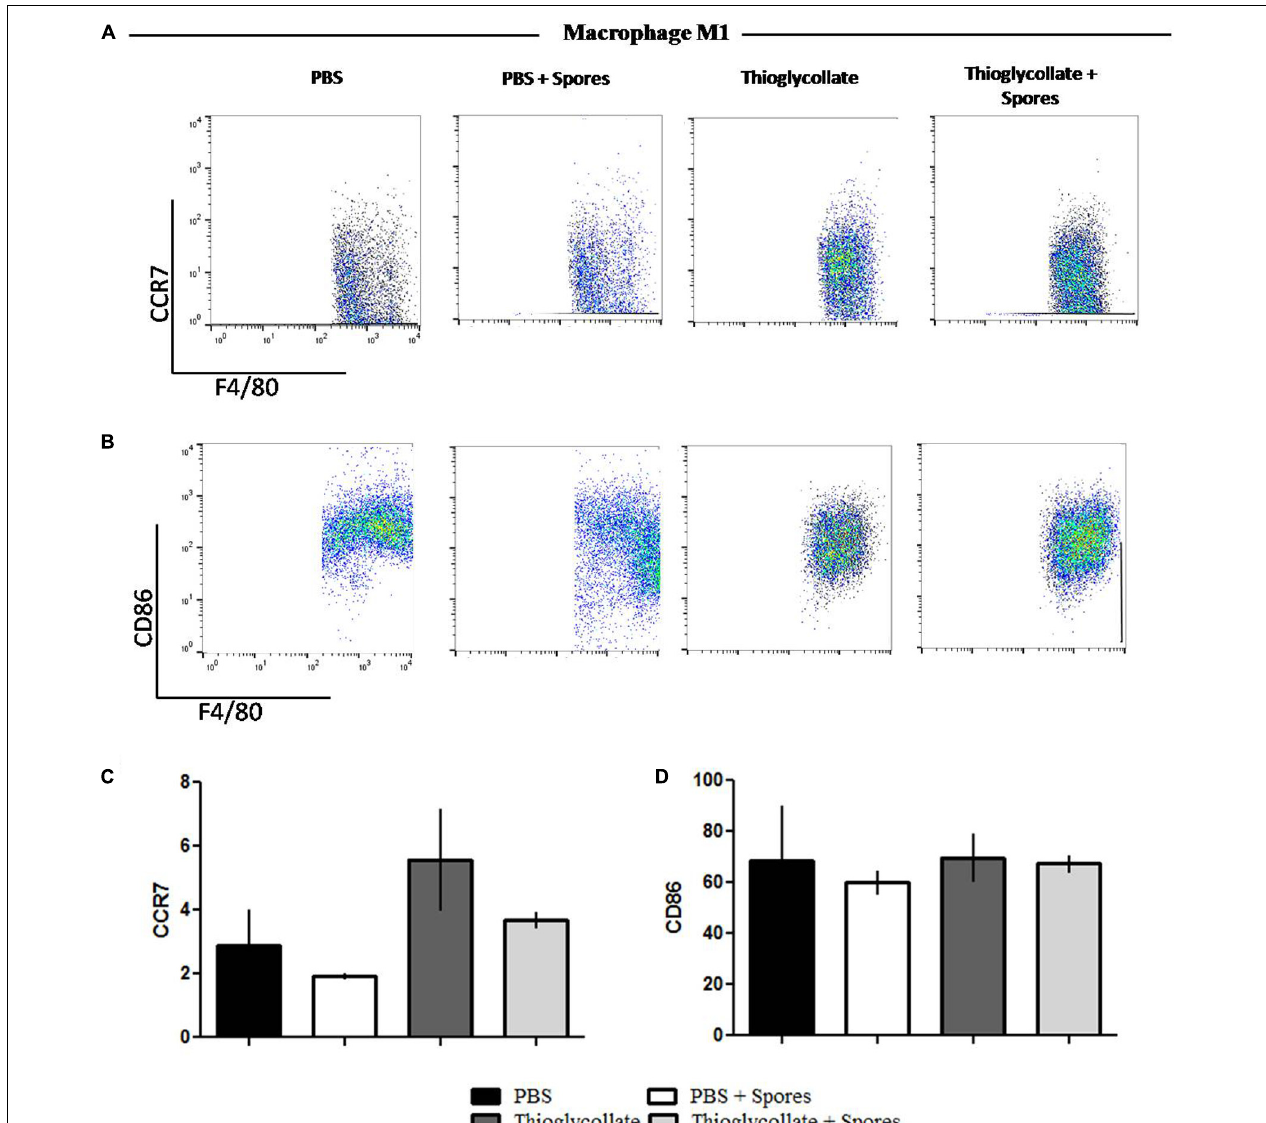
FIGURE 5 | Phenotypical profile of M1 cells. Cells obtained from peritoneal wash of C57BL/6 mice treated or not with spores were collected and stained with monoclonal antibodies for CCR7 (A) and CD86 (B) . Bars from the graphic represent the median fluorescence intensity (MFI) CCR7 (C) and CD86 (D) stained cells obtained by flow cytometry. Data show one histogram representative of three independent experiments with three mice in each group. Results are represented as mean ± SD from one-way ANOVA test followed by Tukey post-test. ∗ p ≤